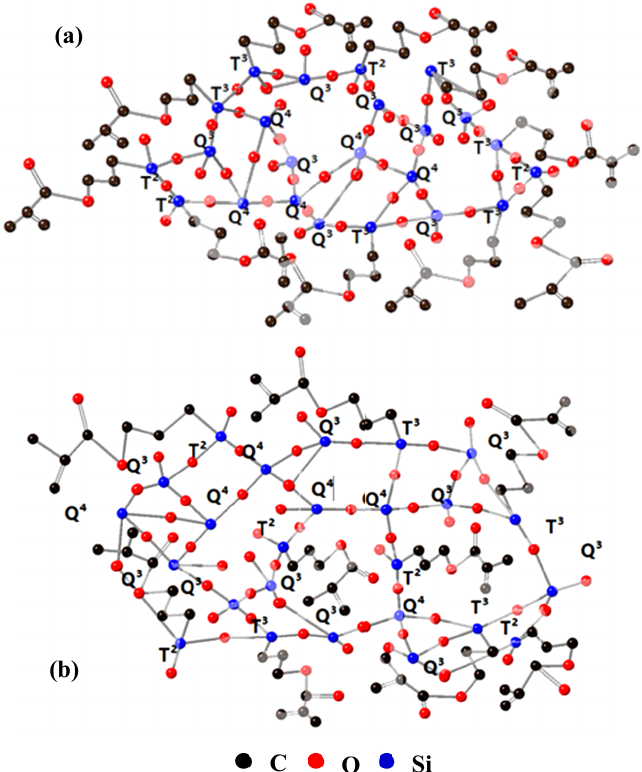
Figure 9. Schematic view of the chemical structure of the polysiloxane hybrids produced ( a ) at room temperature for 45 days, and ( b ) at 65 °C for 4 h. Oxygen atoms not bonded to Si atoms are bonded to H or CH 3 (not shown).